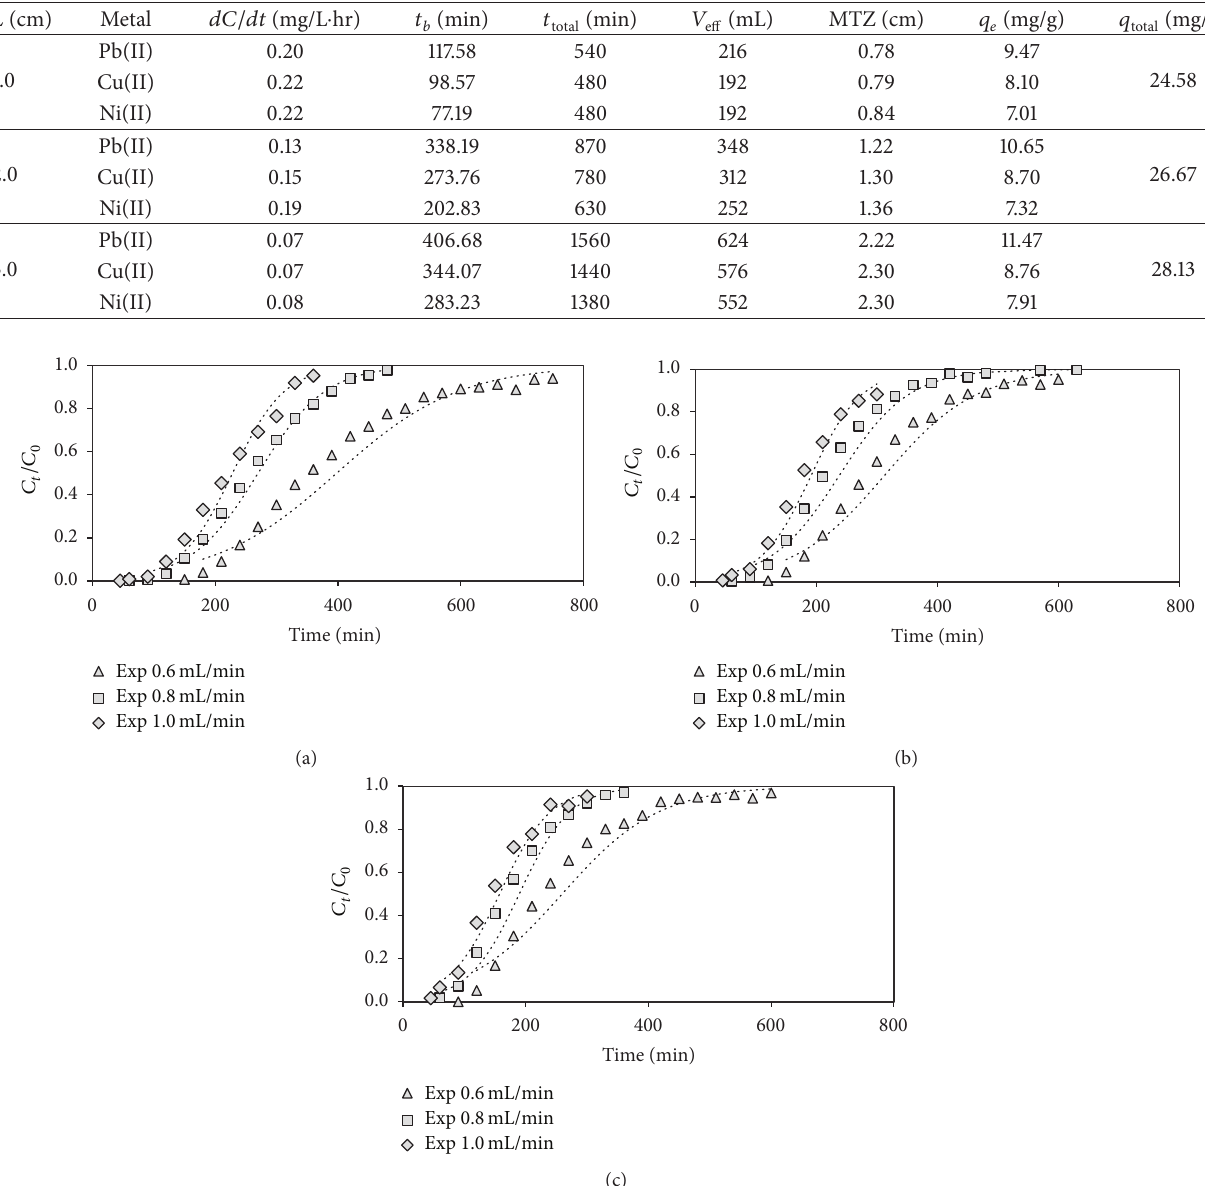
Table 3: Column adsorption data and parameters of ternary metal solution of Pb(II), Cu(II), and Ni(II) at different bed heights with initial metal concentration of 100 mg/L and flow rate of 0.6 mL/min.